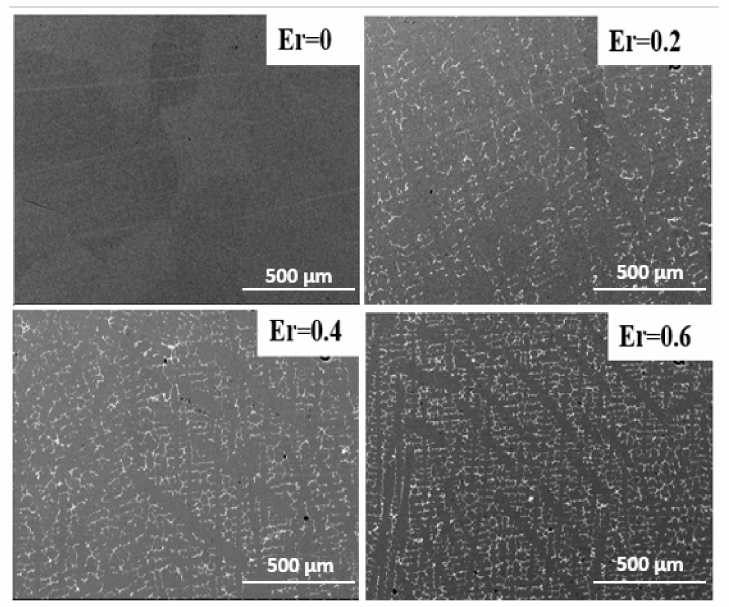
Figure 2. A microstructure of Er-doped (Fe 0.83 Ga 0.17 ) 100 − x Er x ( x = 0, 0.2, 0.4,